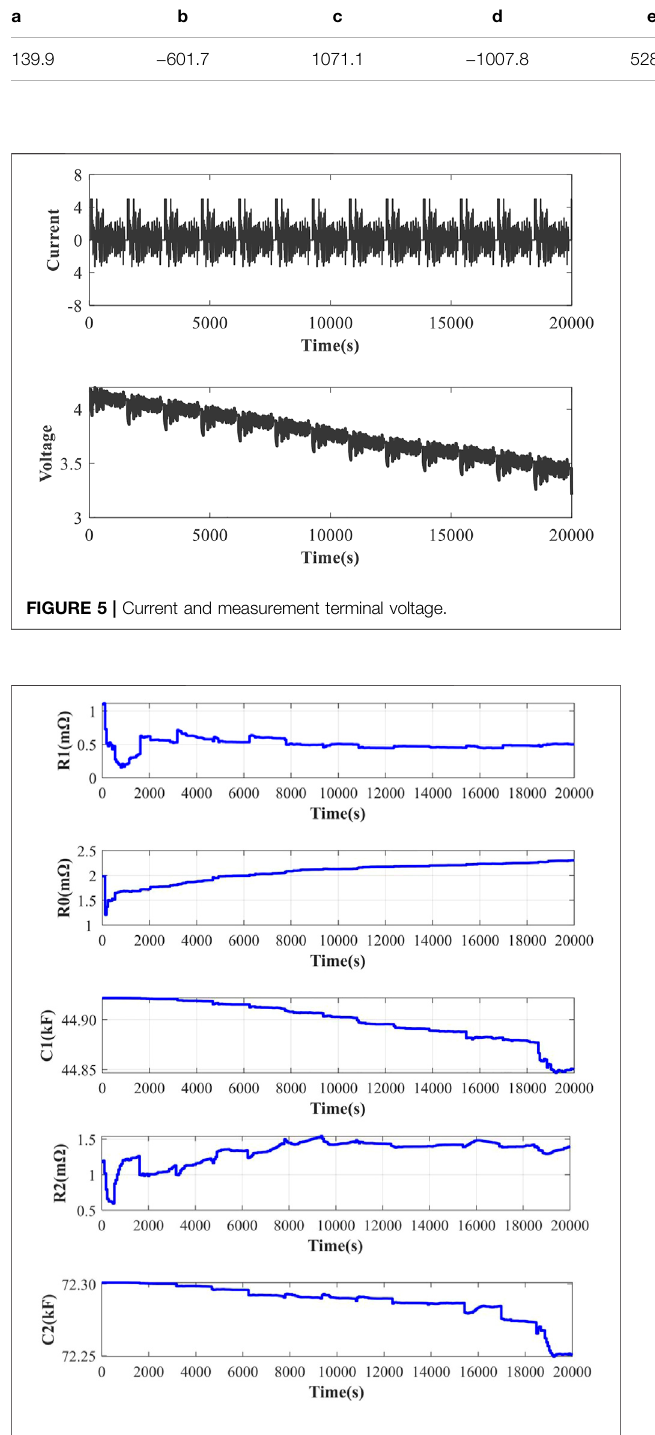
FIGURE 6 | Results of parameter identi fi cation using MIUKF-EKF.